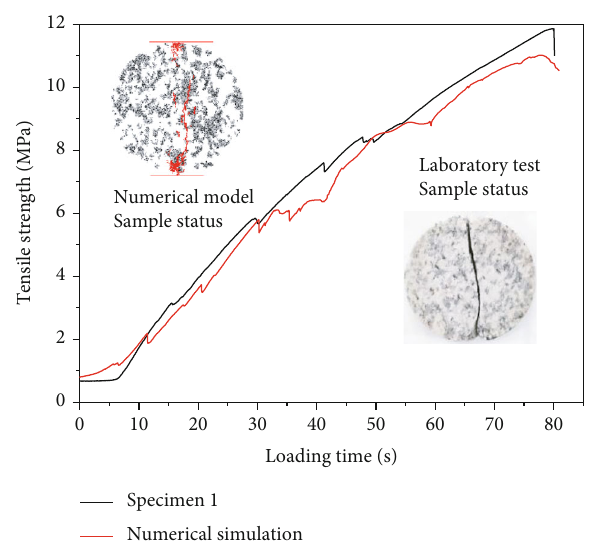
Figure 5: Matching curve of the numerical model and indoor test